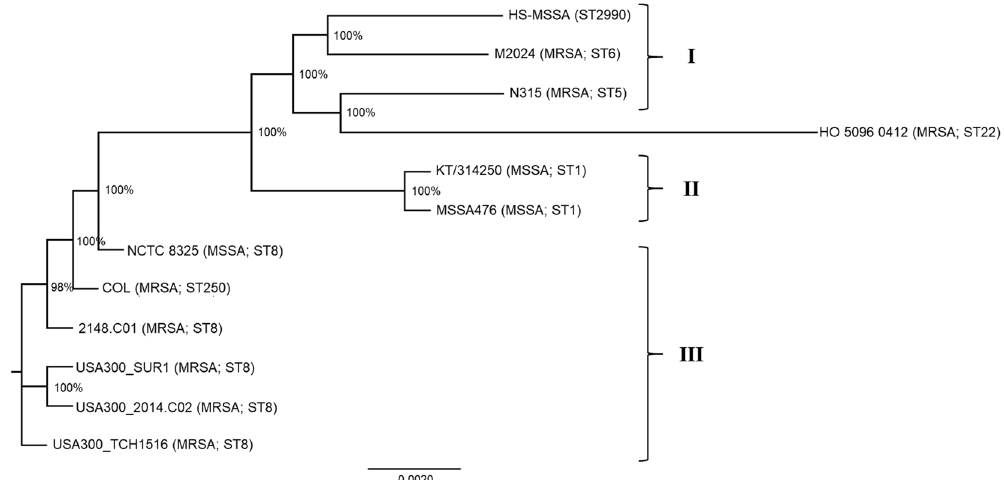
Figure 3. Phylogenomic tree inferred by maximum-likelihood method from SNP-based core genomes alignment of the S. aureus strains. The multiple genome sequence alignments of 11 global S. aureus strains were generated by the online tool REALPHY using S. aureus NCTC 8325 as the reference genome. An unrooted phylogenomic tree was inferred by approximately Maximum Likelihood method using Generalized Time- Reversible (GTR) model with gamma distribution of rates and 100 bootstrap replicates. Bootstrap support value is indicated as a percentage at each node. The roman numerals denote the arbitrary clusters of strains. The ST22 reference genome HO 5096 0412 (NC_017763) resembles a phylogenetic